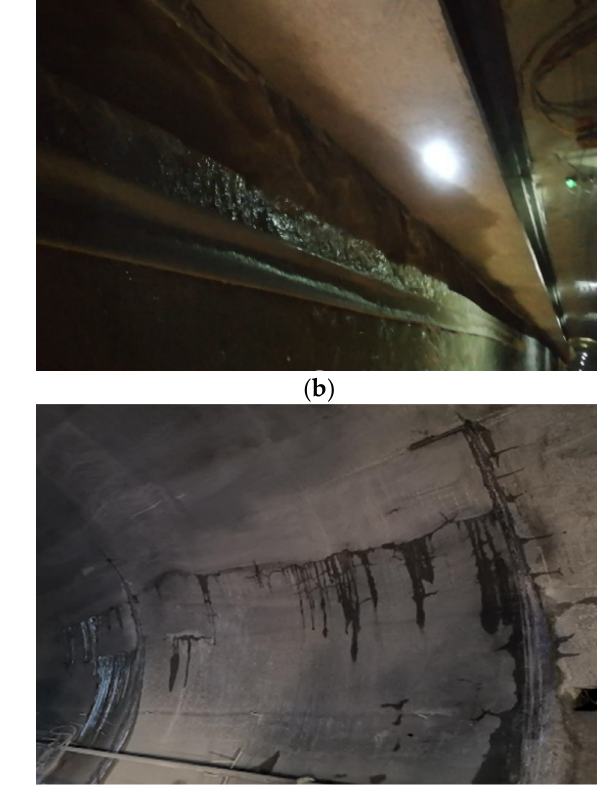
Figure 7. Water inrush in the tunnel after initial treatment. During this process, water seepage occurred in the construction joints of the invert, insufficient water passage capacity of the drainage ditch, calcium carbonate crystals ap- peared in the annular drainage pipe, and cracks appeared in the secondary lining struc- ture of some water inrush areas, etc. (Figure 8a–d).